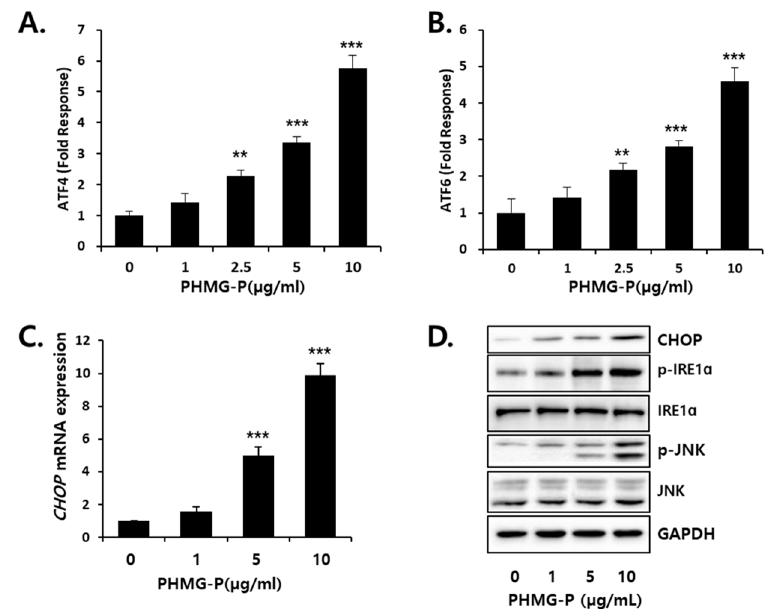
Figure 5. The induction of ER stress in PHMG-P-treated HepG2 cells. The cells were exposed to indicated concentrations of PHMG-P for 4 h, and ER stress response was determined by ( A ) ATF-4- and ( B ) ATF-6-luciferase activity. PHMG-P upregulated the expression of ( C ) CHOP mRNA and ( D ) ER stress-related proteins in HepG2 cells. The cells were treated with PHMG-P at 1, 5, and 10 µg/mL for 16 h. The results are presented as the mean ± SD of triplicate experiments. (** p < 0.01, *** p <